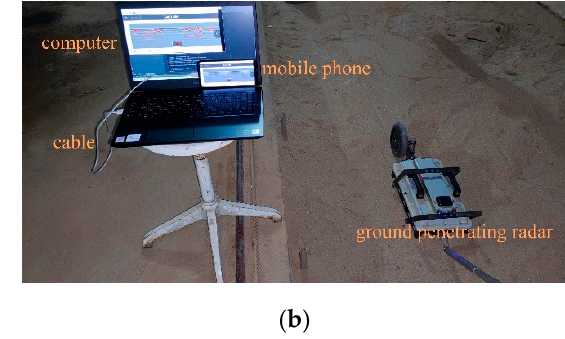
Figure 19. ( a ) Iron experimental material; ( b ) GPR instrument real-time detection system.